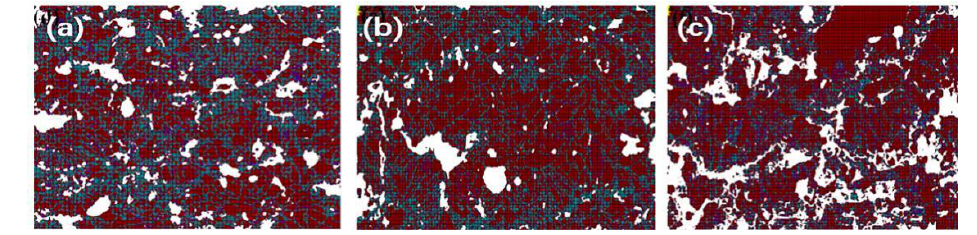
Figure 2. The finite element mesh ( a ) M 1 , ( b ) M 2 and ( c ) M 3 .